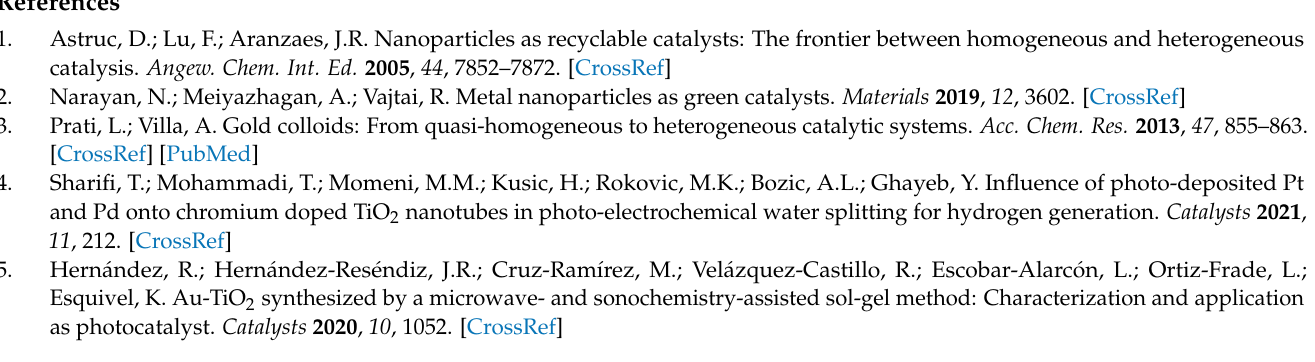
tos. Figure S2: Calibration curves for the Au atom obtained by atomic absorption spectroscopy (AAS). Figure S3: FT-IR spectra of bare MPT and various AuNP-loaded MPT composite particles. Figure S4: Thermal properties of bare MPT and various AuNP-loaded MPT composite particles examined by (a) thermogravimetric analysis (TGA) and (b) differential scanning calorimetry (DSC). Figure S5: Yields of biphenyl by recycling 20AuMPT composite particles in the catalytic homocou- pling of phenylboronic acid in EtOH. Figure S6: Calibration curves for the Au atom obtained by (a) atomic absorption spectroscopy (AAS) and (b) inductively coupled plasma–atomic emission spec- troscopy (ICP-AES). Figure S7: Surface-modified 20AuMPT with hexadecanethiol in water, EtOH, and toluene. Examples of AuNP size calculations using the XRD peaks via the Scherrer